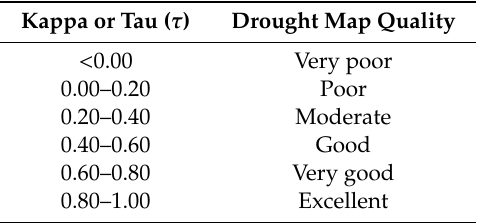
Table 3. Quality of drought classification associated with kappa and tau ( τ )